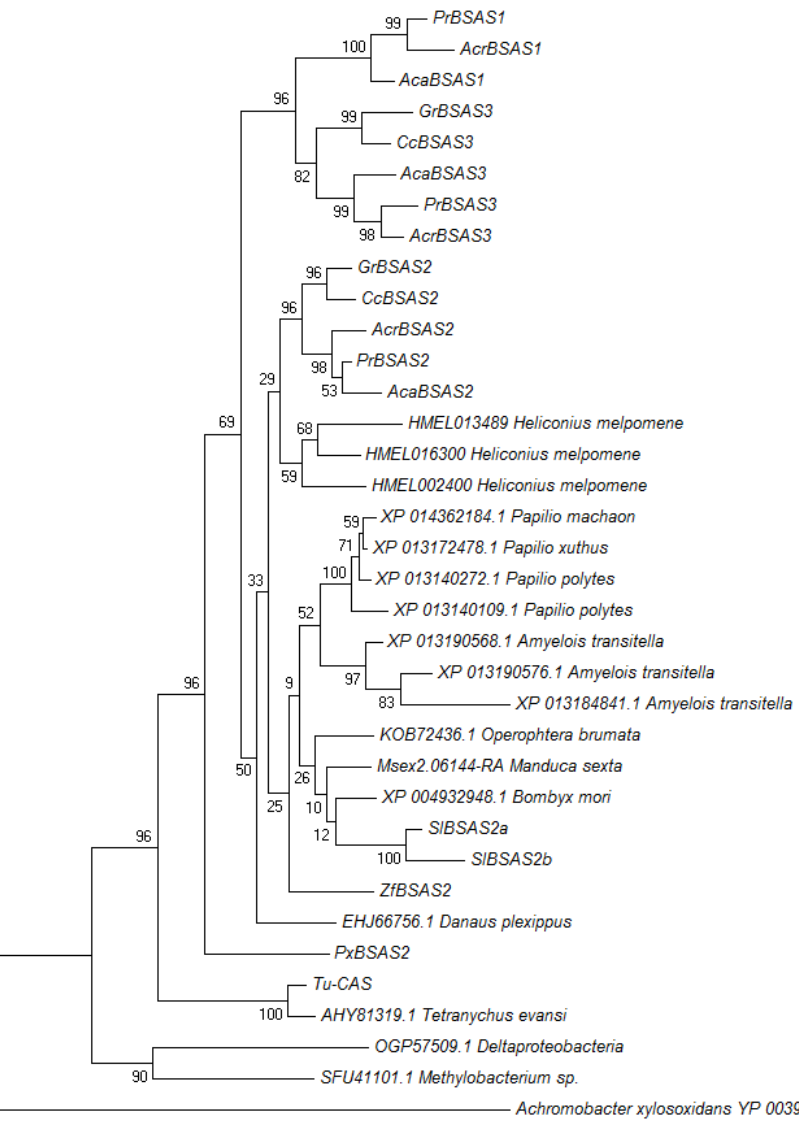
Figure 7. Phylogenetic relationship of characterized β-cyanoalanine synthases and uncharacterized homologs from lepidopteran species. Two enzymes from mites were also included. Uncharacterized bacterial homologs were used to root the tree. The Maximum Likelihood Tree was generated with 1000 bootstrap replications. Branch lengths refer to the number of substitutions per site, a scale bar is given below the tree.